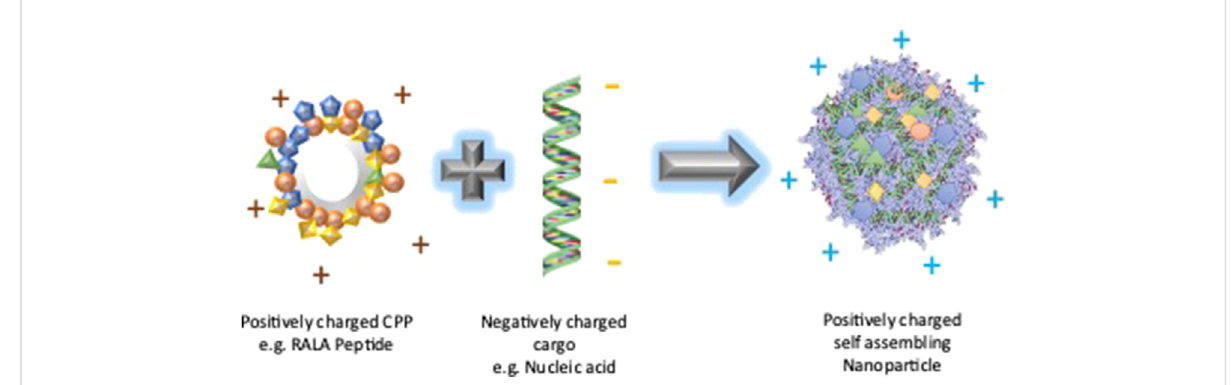
FIGURE 5 RALANanoparticleformation.ThecationicRALApeptideformsaself-assemblednanoparticlewithanegativelychargednucleicacidcargodue to the electrostatic interaction between them. The resultant nanoparticle is expected to have a positive charge due to the neutralization of the negative charge of the nucleic acid by the positively charged